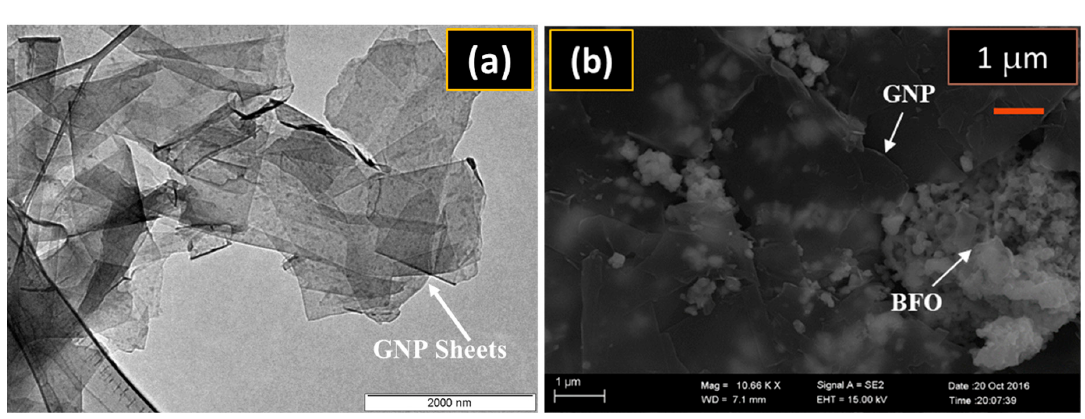
Figure 2. ( a ) TEM results of GNPs, and ( b ) SEM of BFO/GNP hybrid structure.